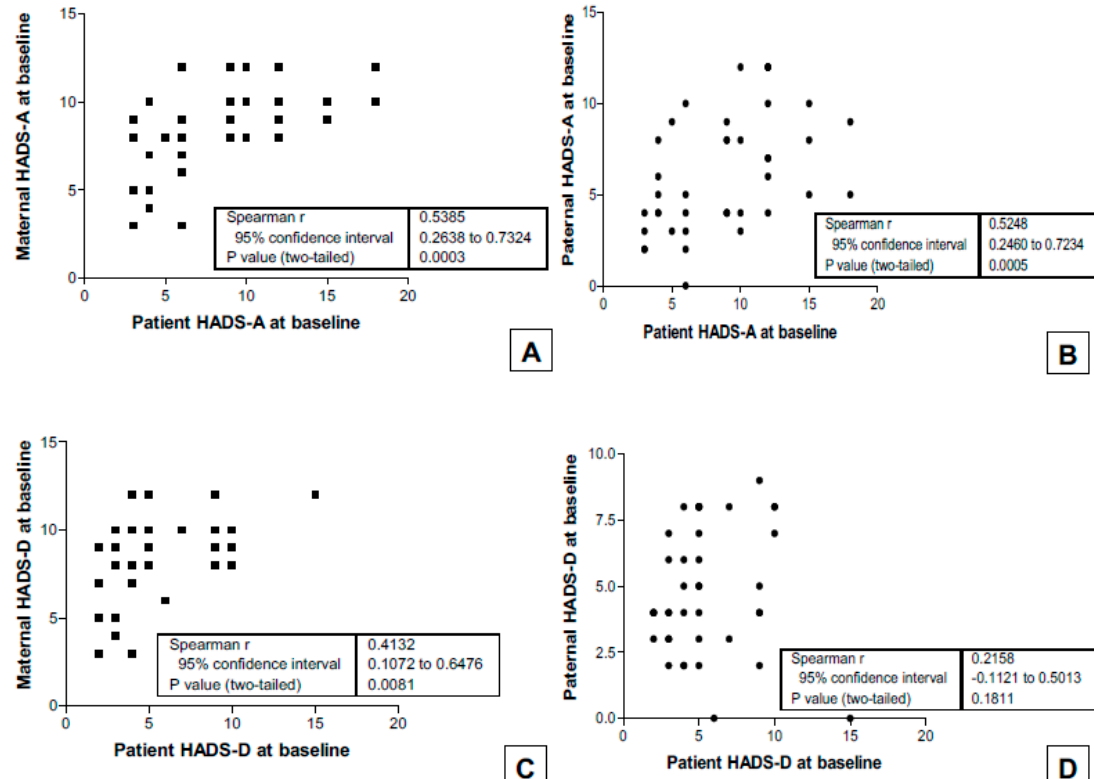
Figure 1. ( A ) Relationship between HADS-A in the mothers and in the adolescents at baseline; ( B ) relationship between HADS-A in the fathers and in the adolescents at baseline; ( C ) relationship between HADS-D in the mothers and in the adolescents at baseline; ( D ) the relationship between HADS-D in the fathers and in the adolescents at baseline.